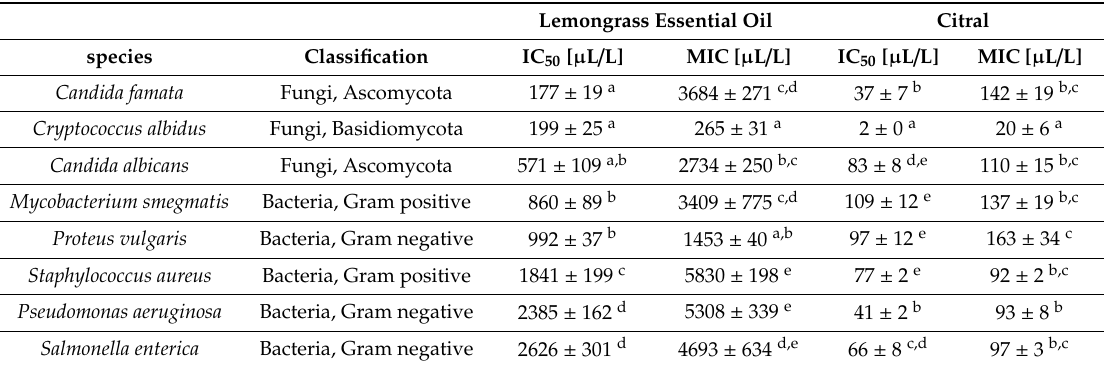
Table 1. Antimicrobial activity of lemongrass essential oil.